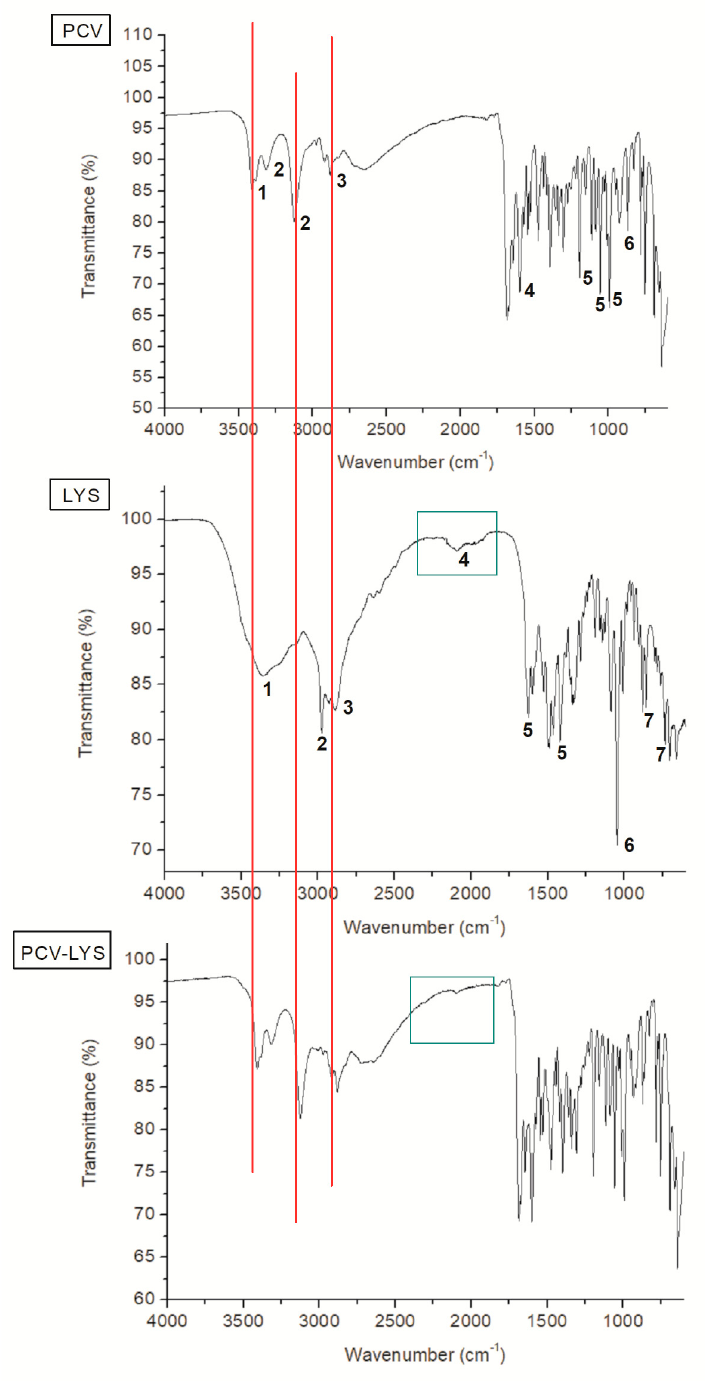
Figure 4. Infrared Fourier transform spectroscopy (FTIR) spectra of PCV, LYS and PCV-LYS. Table 1. Position and assignment of PCV and LYS FTIR bands.